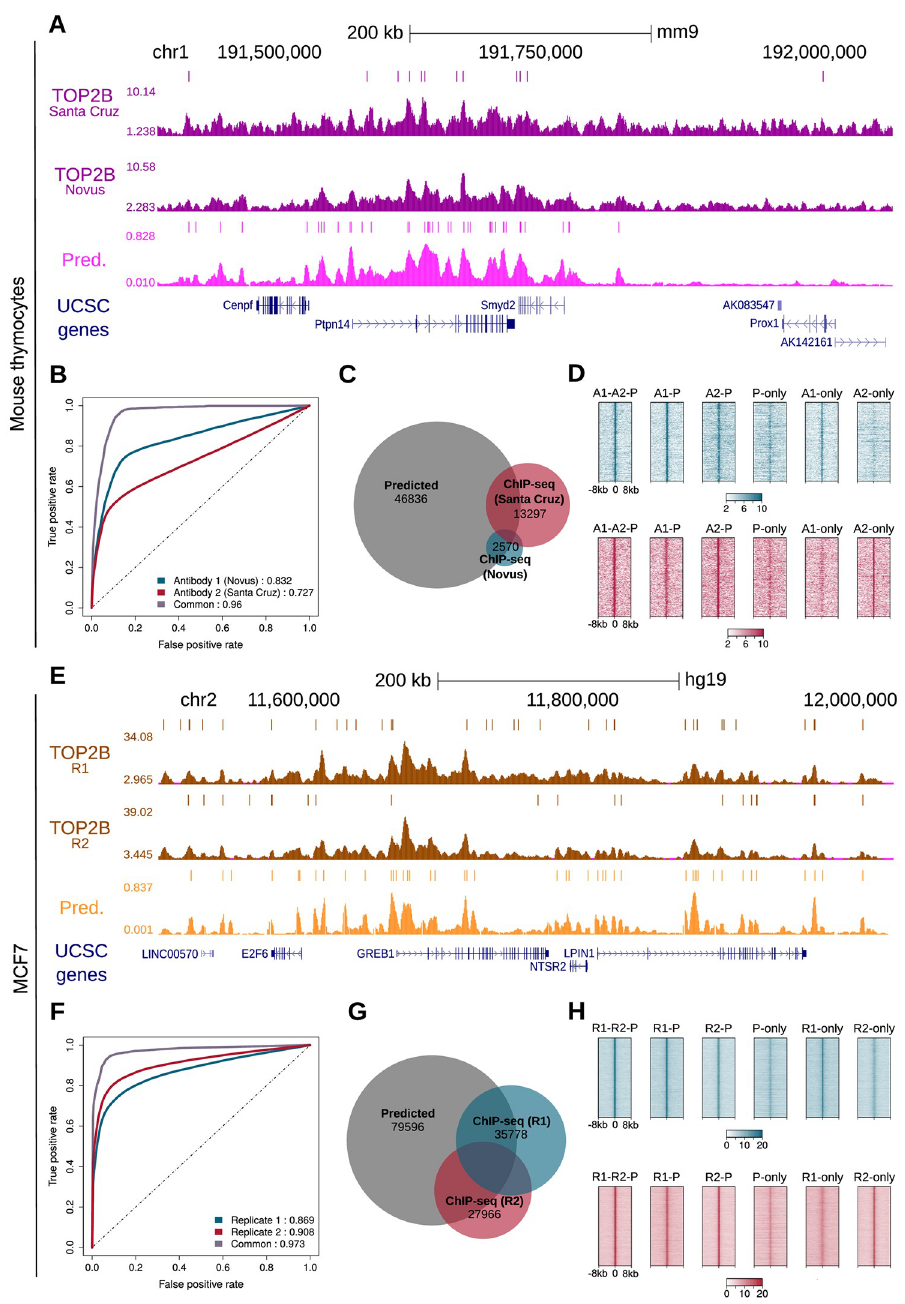
Fig 6. Validation of TOP2B model in mouse thymocytes and human MCF7. A . TOP2B predictive and ChIP-seq tracks of mouse thymocytes in a selected region of the mouse genome. Identified peaks are displayed above the signals. B . ROC curves and AUC values for the prediction of TOP2B peaks detected using Novus and Santa Cruz antibodies. C . Venn diagram showing the overlaps between predicted TOP2B peaks and the two sets of experimental peaks. D . Heatmap representations of TOP2B ChIP-seq reads enrichment within ± 8 kb of several set of peaks: predicted and confirmed by HOMER calls of both antibodies (A1-A2-P), predicted and confirmed only by Novus antibody (A1-P) or Santa Cruz (A2-P), only predicted (P-only), only detected by Novus (A1-only) and only detected by Santa Cruz (A2-only). For illustration purposes, the same number of randomly selected peaks is represented in all the heatmaps. E . TOP2B predictive and ChIP-seq tracks of MCF7 in a selected region of the human genome. Identified peaks are displayed above the signals. F . ROC curves and AUC values for the prediction of TOP2B peaks in two replicates performed in MCF7. G . Venn diagram showing the overlaps between predicted TOP2B peaks and the two sets